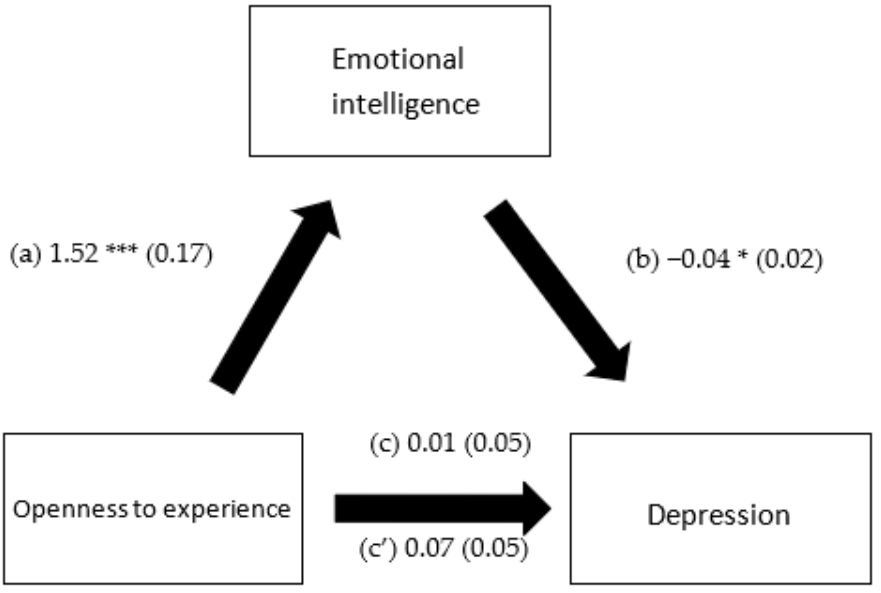
Figure 2. (a) Relation between openness to experience and emotional intelligence (R 2 = 0.294); (b) relation between emotional intelligence and depression (R 2 = 0.284); (c) total effect of the relation between openness to experience and depression (R 2 = 0.270); and (c’) direct effect of the relation between openness to experience and depression. Numbers are displayed as regression coefficients (standard error). * p < 0.05; *** p < 0.001.